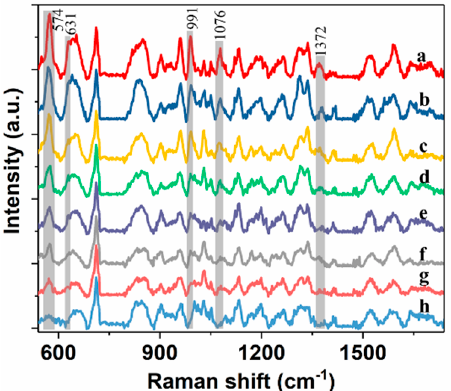
Figure 3. SERS spectra of wheat extract solution with pirimiphos-methyl residue of 25, 10, 5, 2.5, 1, 0.5, 0.2 and 0.1 mg/L ( a – h ).